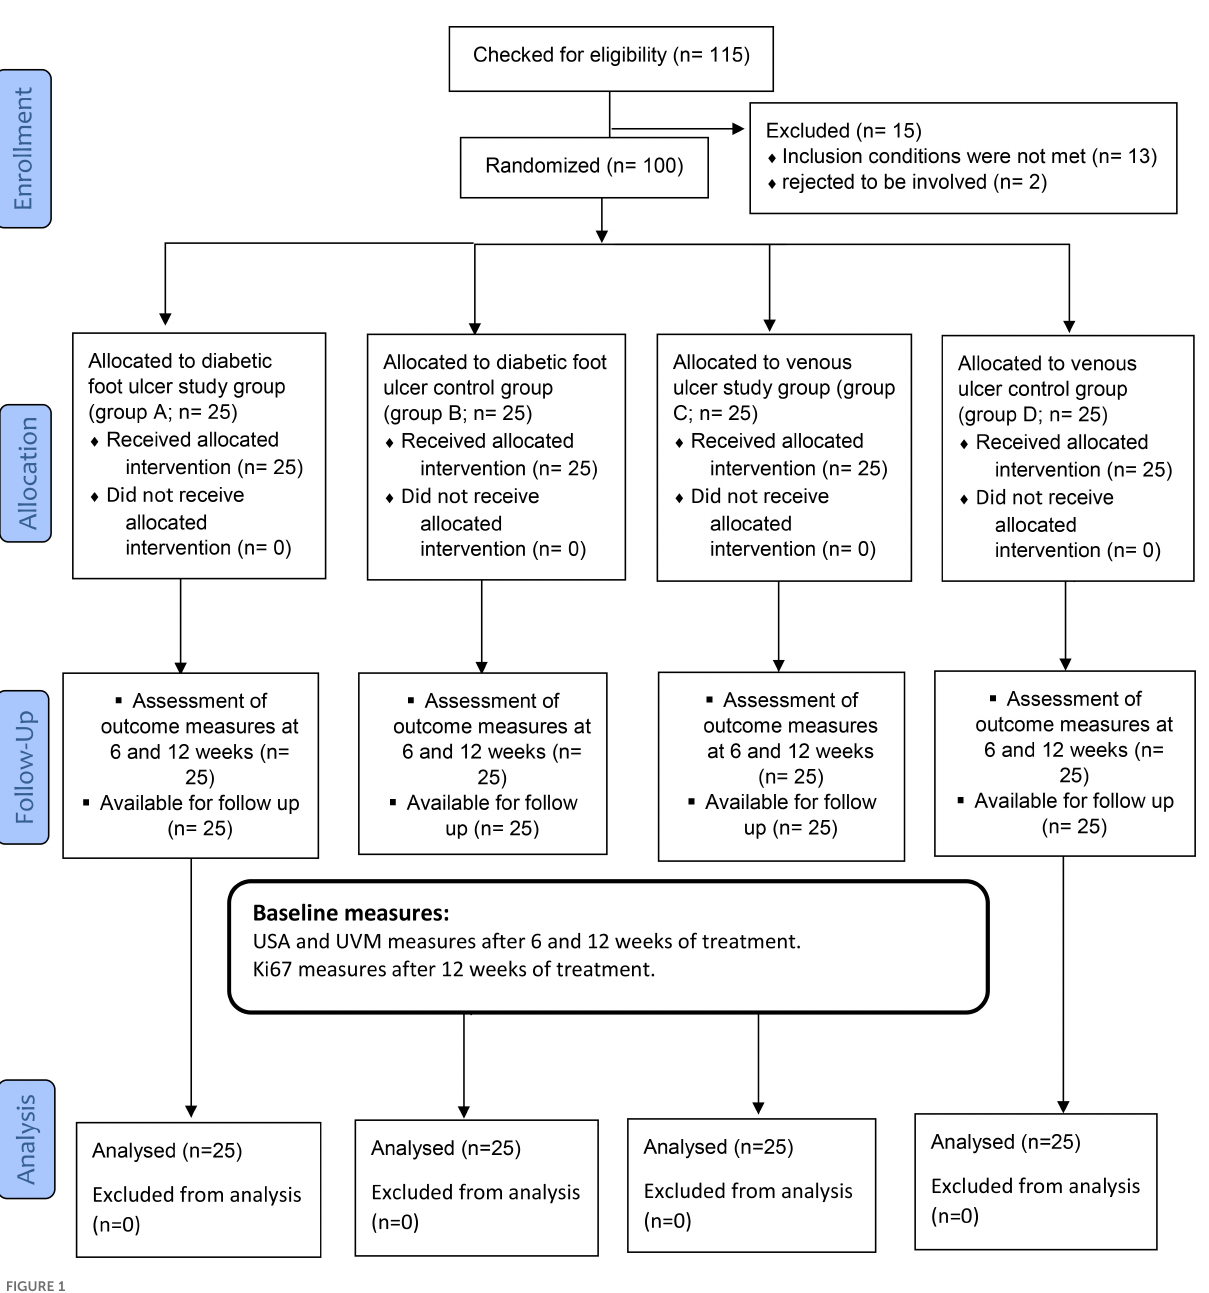
FIGURE1 The flowchart of the